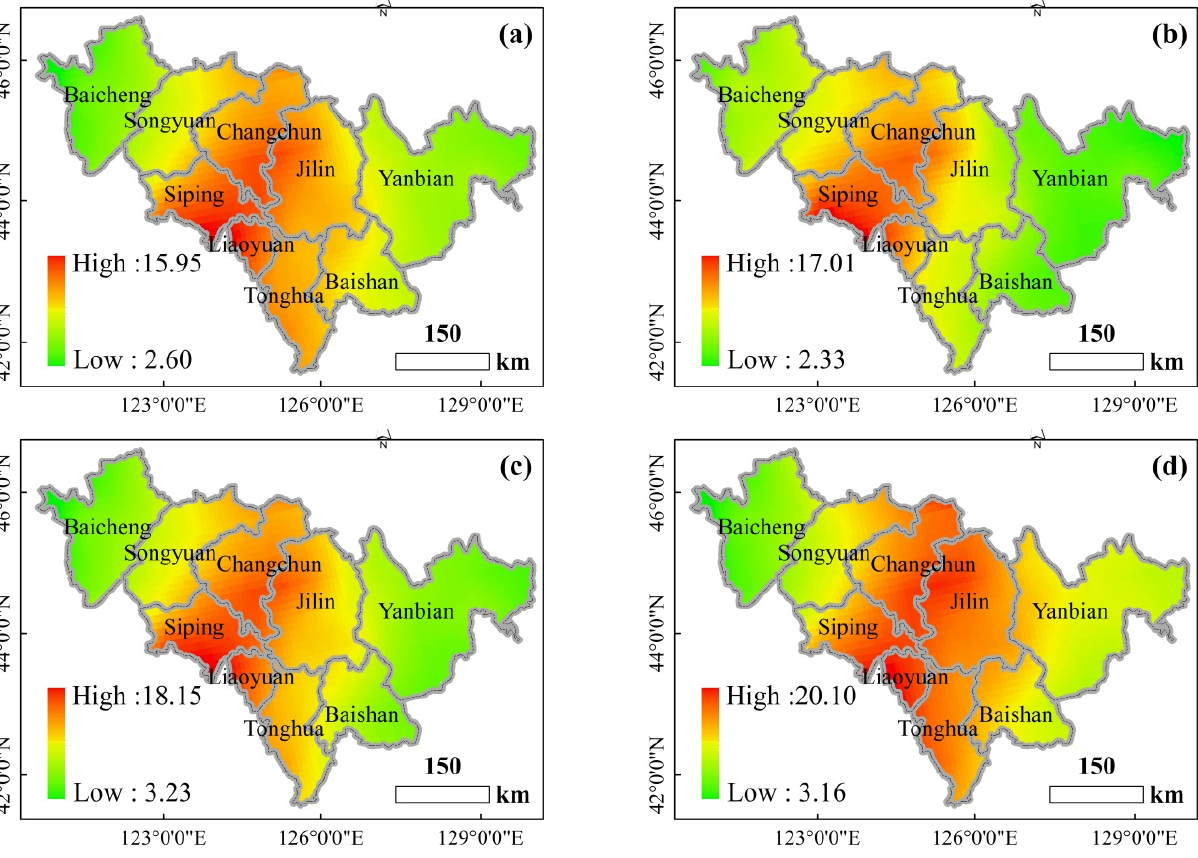
Figure 9. The spatial distribution of ρ (SO 2 ) in different seasons in 2015–2020. (( a ). Spring, ( b ). Summer, ( c ). Autumn, ( d ). Winter).